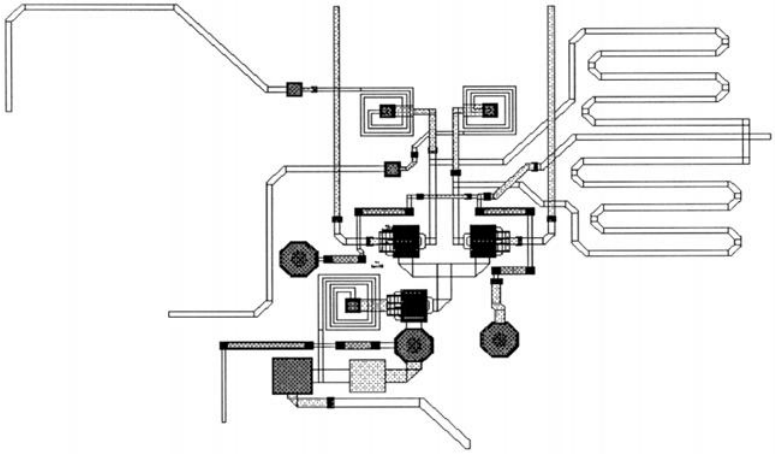
FIGURE 24 Final layout of the active part of the BPSK